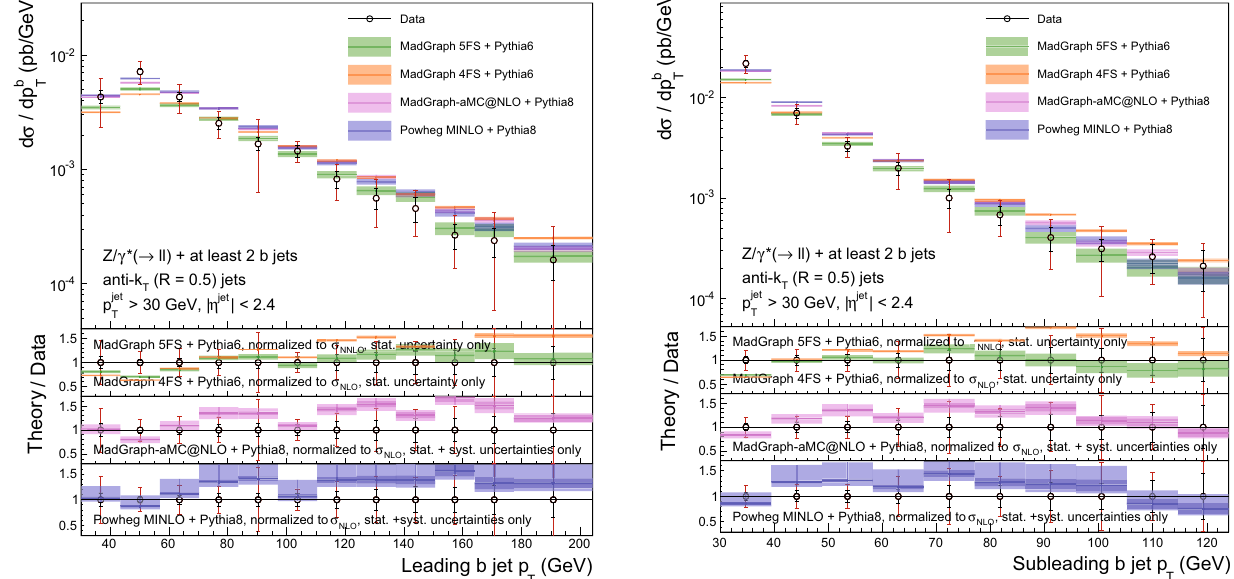
Fig. 9 Differential fiducial cross section for Z(2b) production as a function of the leading b jet p T , compared with the MadGraph 5FS, MadGraph 4FS, MadGraph5 _a MC@NLO , and powheg minlo the- oretical predictions ( shaded bands ), normalized to the theoretical cross sections described in the text. For each data point the statistical and the total (sum in quadrature of statistical and systematic) uncertainties are represented by the double error bar . The width of the shaded bands represents the uncertainty in the theoretical predictions, and, for NLO calculations, theoretical systematic uncertainties are added in the ratio plots with the inner darker area representing the statistical component only